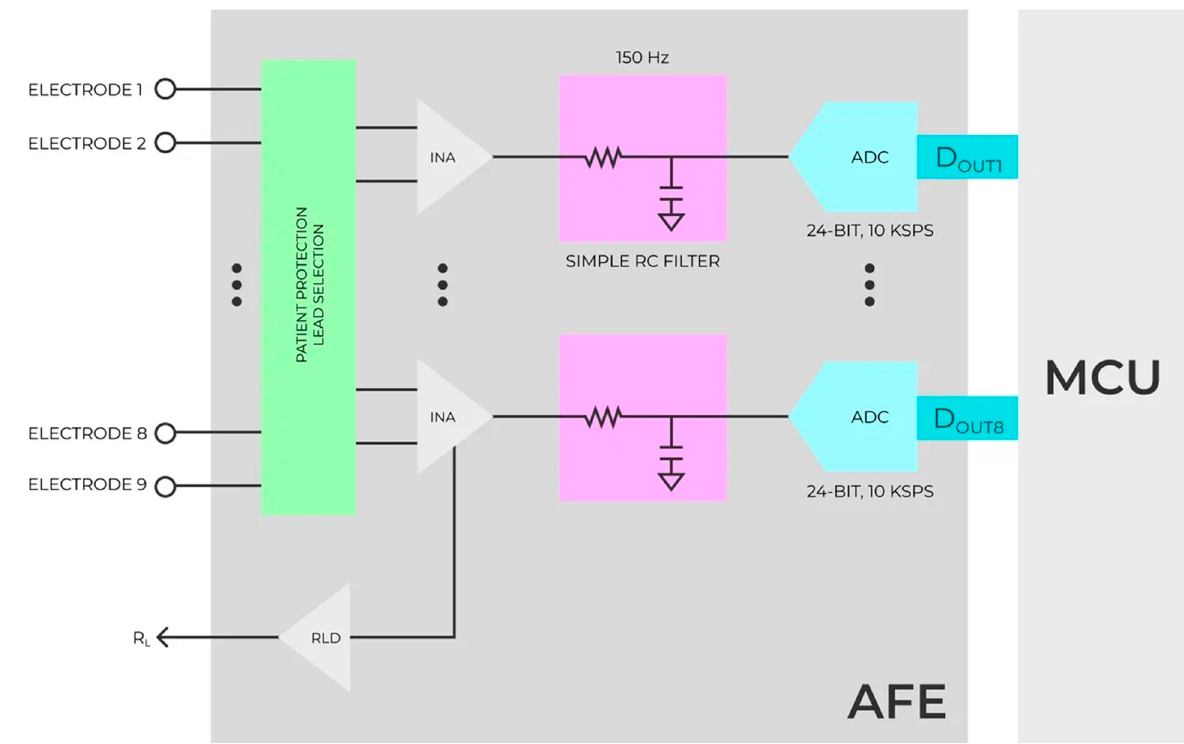
Figure 11. Structure of bioamplifier circuit based on AFE with sigma-delta ADC.